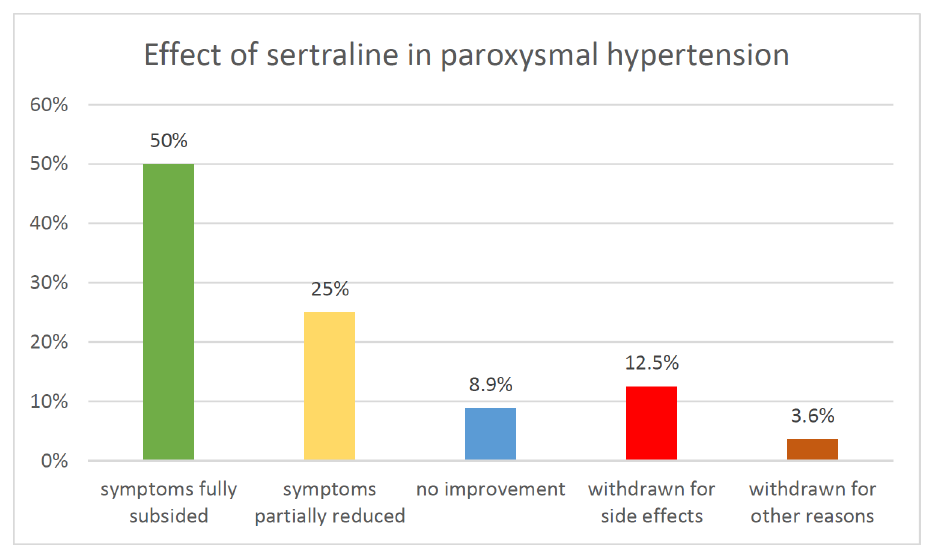
Fig. 1. Effect of sertraline in paroxysmal hypertension. Symptoms of paroxysmal hypertension fully subsided in 50% and were partially reduced in 25% patients after 3 months of treatment with sertraline. In 12.5% patients, administration of sertraline had to be stopped for side